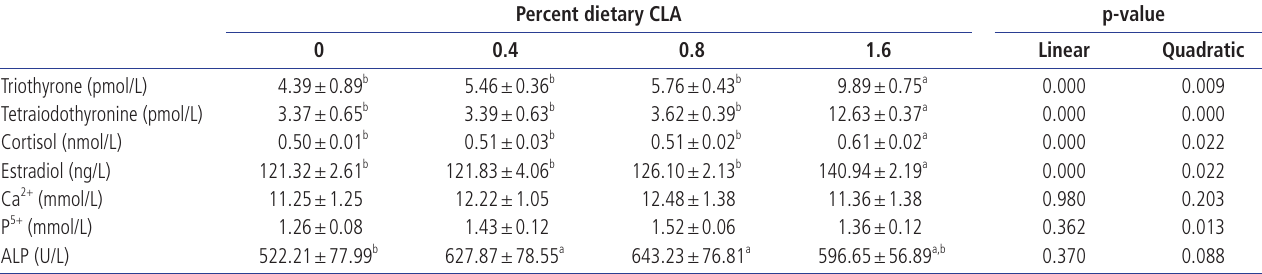
Table 7. Influence of dietary CLA on serum components